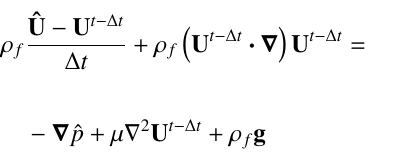
Table 1. Summary of forces and torques acting on the particle. For a full description of the contact forces, refer to